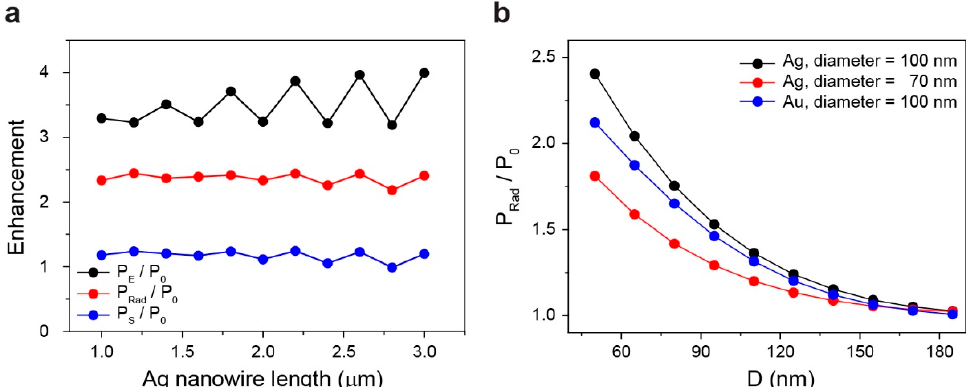
Figure 2. Calculated power enhancements. ( a ) Total power enhancement (black), radiative power enhancement (red), and scattered power enhancement (blue) calculated as a function of the Ag nanowire length when the diameter of nanowire = 100 nm, D = 50 nm, and θ = 0°. ( b ) Radiative power enhancement calculated as a function of D for Ag and Au nanowires. The diameters of 100 nm (black) and 70 nm (red) for the Ag nanowire and the diameter of 100 nm (blue) for the Au nanowire were examined.